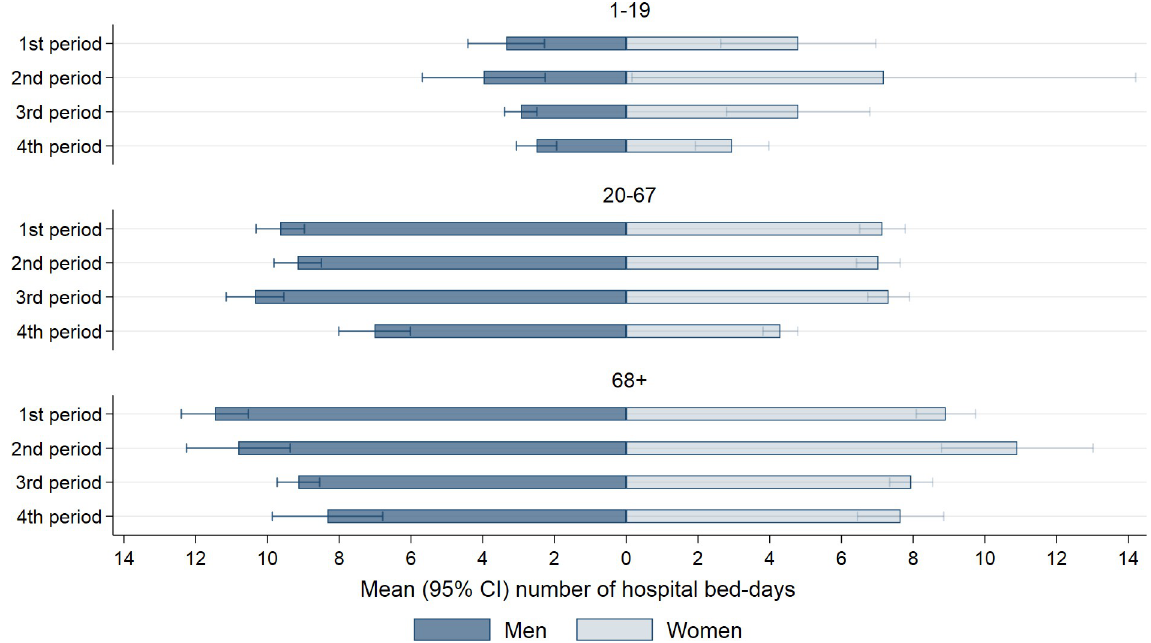
Fig 5. Number of bed-days spent in inpatient care. The mean (95% confidence intervals) number of bed-days spent in inpatient care, for women and men in different age groups, during four waves/periods of the pandemic: February 26 th , 2020 –February 16 th , 2021 (1 st period), February 17 th , 2021 –July 10 th , 2021 (2 nd period), July 11 th , 2021 –December 27 th , 2021 (3 rd period), and December 28 th , 2021 –January 14 th , 2022 (4 th period), among persons having at least one visit in inpatient